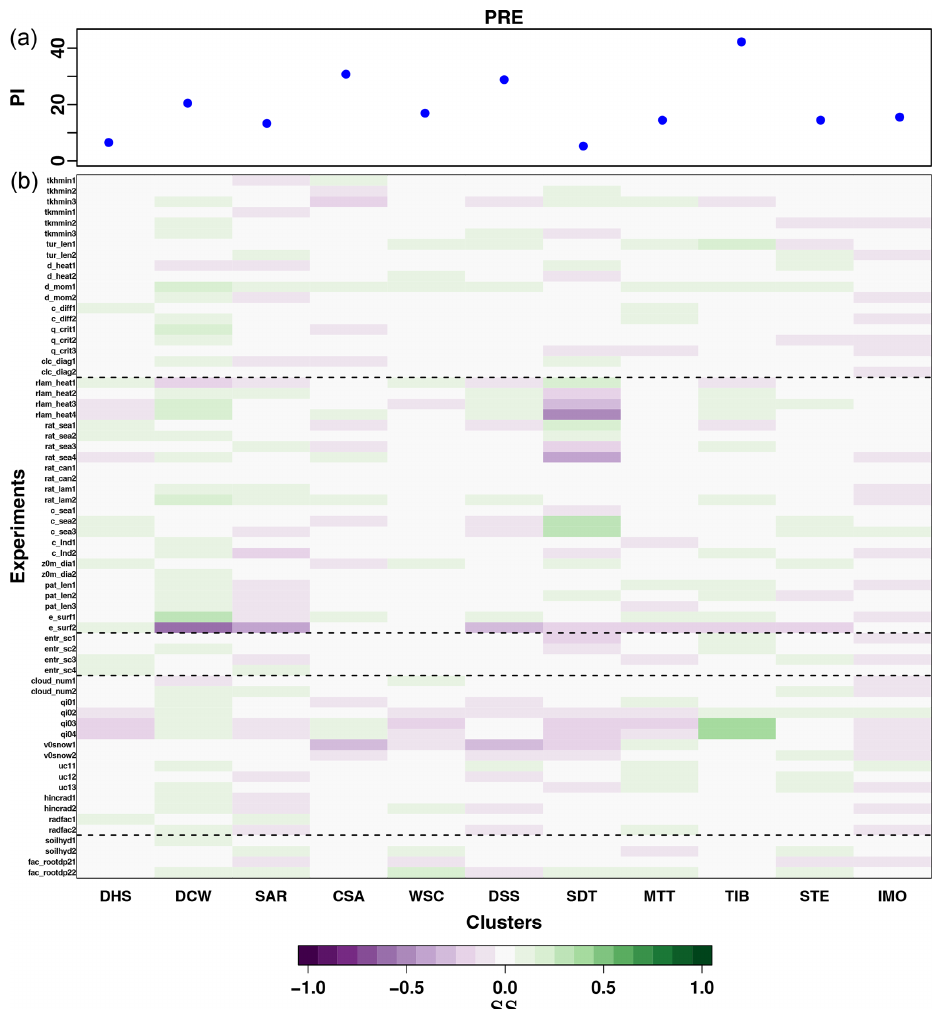
Figure 6. (a) PI calculated for precipitation (PRE) for the reference experiment with default parameter values, over each of the 11 Central Asia subregions. (b) Changes in the SS of each performed experiment, calculated with respect to the default simulation, for PRE: green (violet) values indicate a better (worse) agreement with observations with respect to the default simulation. The experiments for each parameter are enumerated in an increasing order, according to its tested values, from the lowest to the highest. The different simulations are additionally grouped depending on the main physical scheme the tested parameter is characteristic of, in the same way as they are in Table